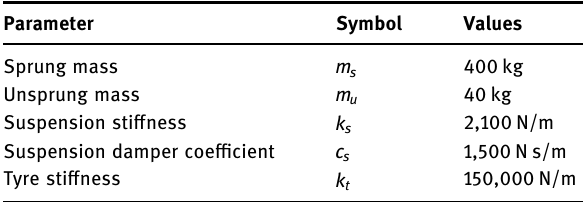
Table 1: Parameters of semi - active suspension system [ 12